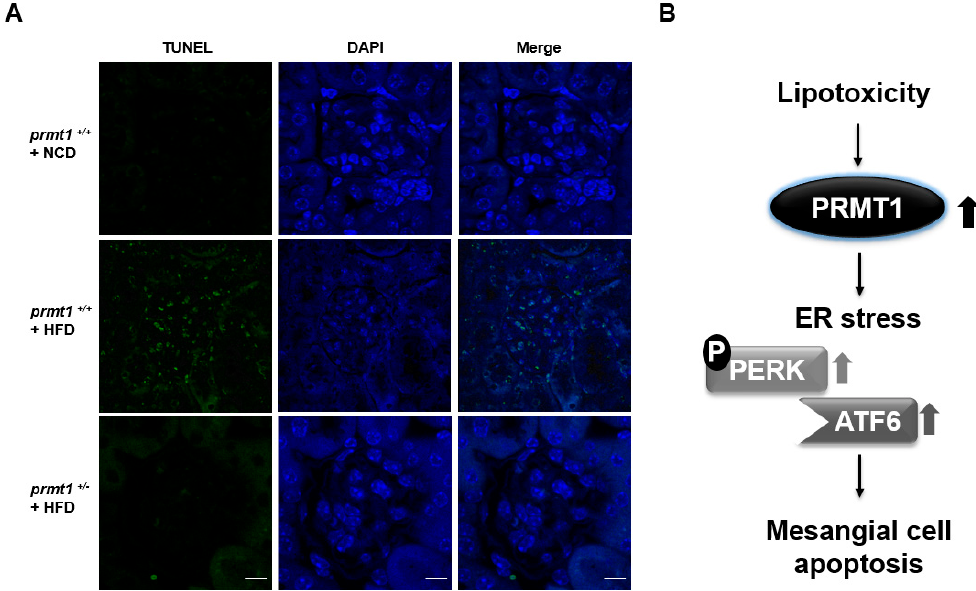
Figure 4. High fat diet (HFD)-induced glomerular apoptosis is attenuated in PRMT1 haploinsufficient mice. ( A ) Kidney sections were subjected to terminal deoxynucleotidyl transferase dUTP nick-end labeling (TUNEL) assay as described in “Materials and Methods”, (scale bar: 20 μ M); ( B ) summarized scheme; lipotoxicity-induced PRMT1 exacerbates mesangial cell apoptosis via ER stress.